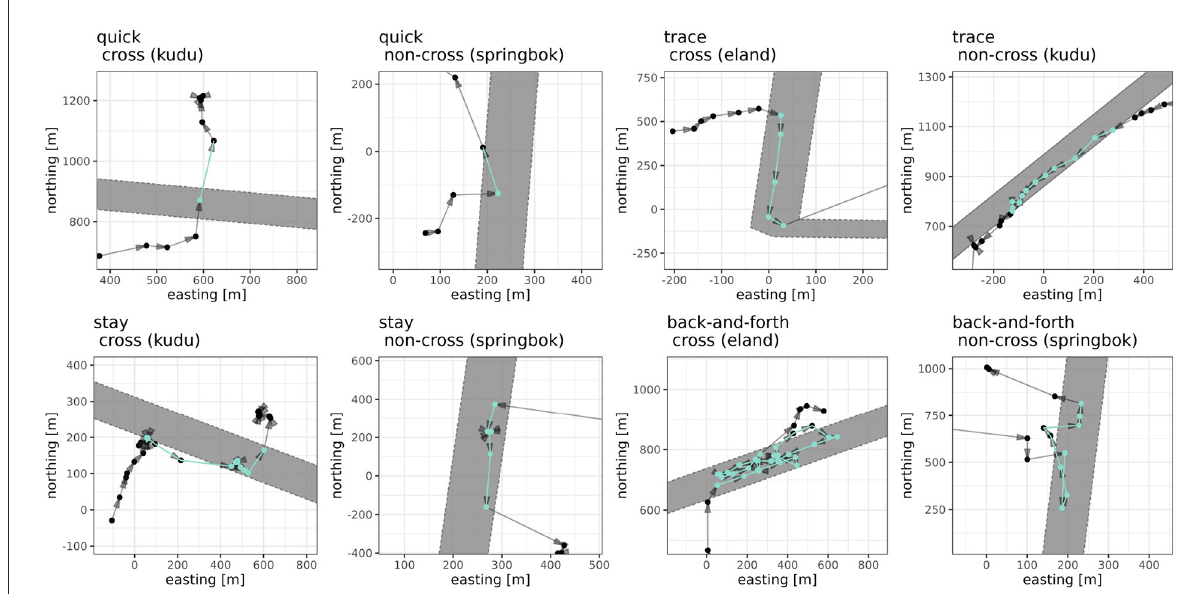
FIGURE2 Examples of classified fence interactions. Shown are examples for each of the classified types ( quick, trace, stay, back-and-forth ) and subtypes ( cross, non-cross ), see panel titles. Gray area depicts the fence area (fence line with a 50 m buffer).